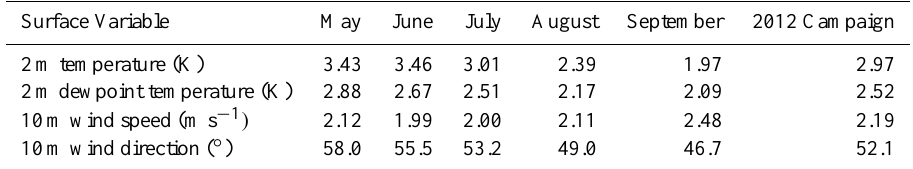
Table 4. 2012 WRF v3.4.1 model RMSEs for selected surface variables. Wind speed and direction errors are computed using observations ≥ 3kn ( ∼ 1.5ms − 1 ) . Positive direction is